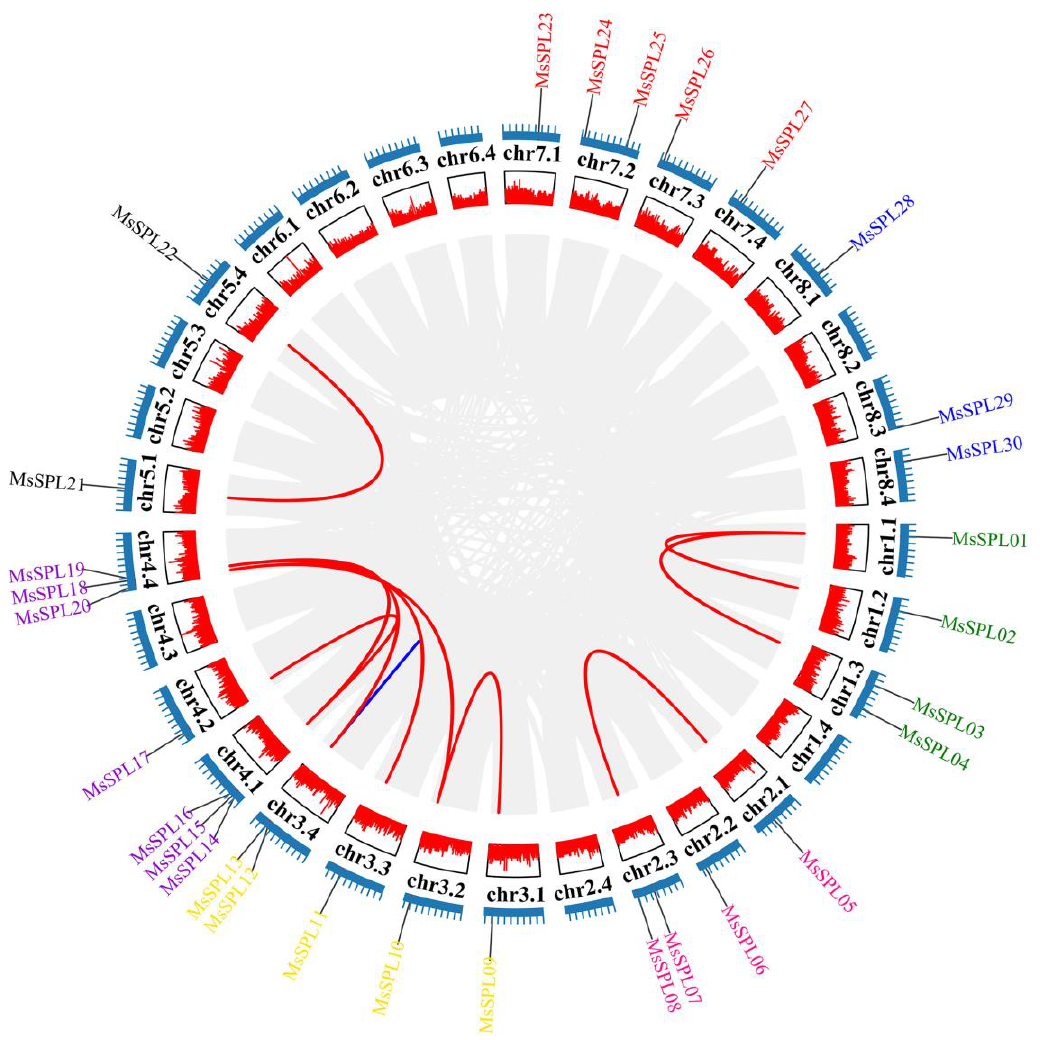
Figure 5. Chromosome distribution and collinearity investigation of MsSPL genes in alfalfa. Gray background indicates all syntenic blocks, red and blue lines indicate segmental and tandem duplications, respectively.